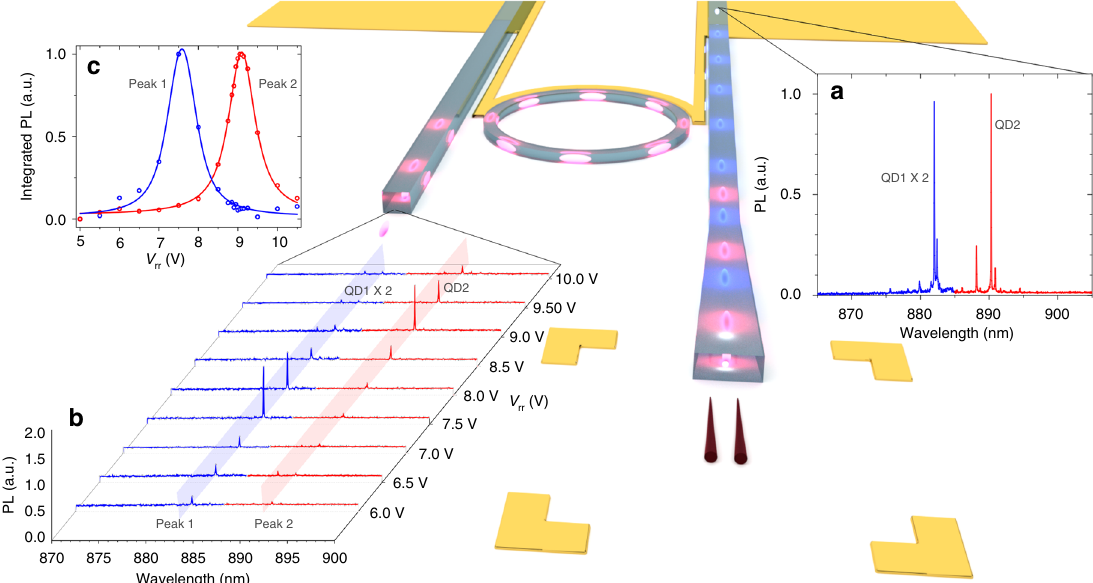
Fig. 4 Wavelength mulitplexing of quantum emitters. Artistic image of multiplexing/demultiplexing of two quantum emitters coupled to a photonic circuit with integrated tunable fi lters. The two nanowires are butt-coupled to a SiN waveguide, each of them emitting photons independently with different colours (depicted as red and blue in this case). The fl exibility of the process allows for the possibility of wavelength and modal multiplexing of selected single-photon sources to an already fabricated and characterized photonic circuit, thus making the process highly deterministic. Details of the fabrication and nanowire transfer process are included in the Methods section. a Collected emission from the through-port waveguide, consisting of a wavelength-multiplexed signal from QD1 and QD2. The spectra are highlighted in red and blue to indicate the individual emission from QD1 and QD2. b Selected excitonic transitions of QD1 and QD2 are fi ltered deterministically to the drop-port waveguide as a function of the on-chip fi lter tuning voltage. c Integrated intensity of QD1 and QD2 in the drop-port as a function of voltage. As the voltage is controlled, QD1 and QD2 follow the Lorentzian shape of the ring resonator transmission